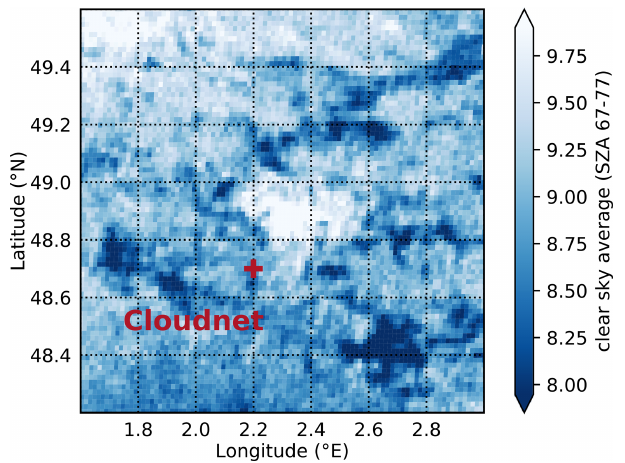
Figure 2. Average (SZA bins 67–77) of clear-sky reflectance CS loc obtained by Eq. (3). The location of the CloudNet station at Palaiseau used for validation is marked in